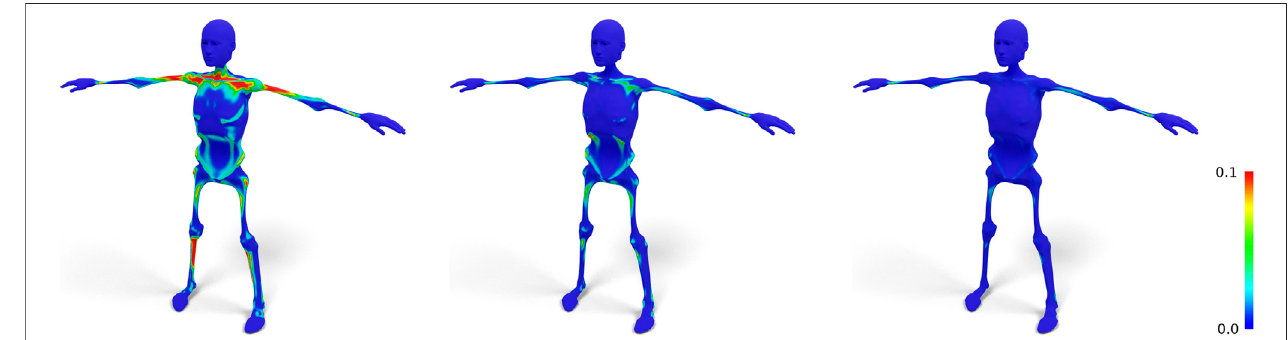
FIGURE 4 | Standard nonrigid registration from skin to skeleton (left) results in a bad tangential alignment of corresponding triangles, causing sheared prisms, which we visualize by color-coding the alignment error ( Eq. 4 ). Using fi xed correspondences reduces this error (center) . Also shifting closest point correspondences with bad alignment reduces the error even further (right)